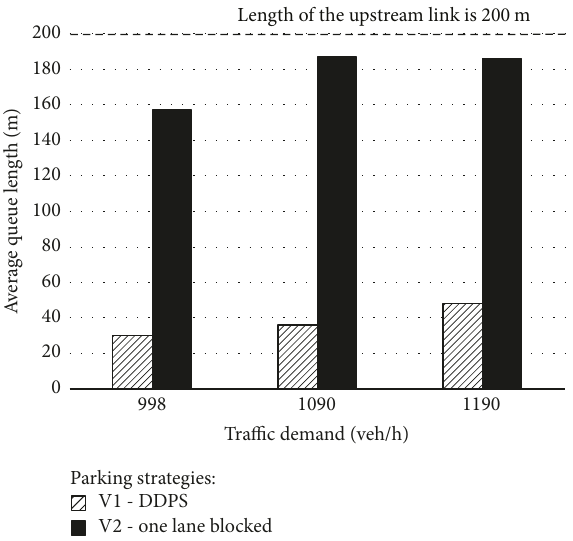
Figure 7: Average queue length (m) in the validation scenarios: V1 and